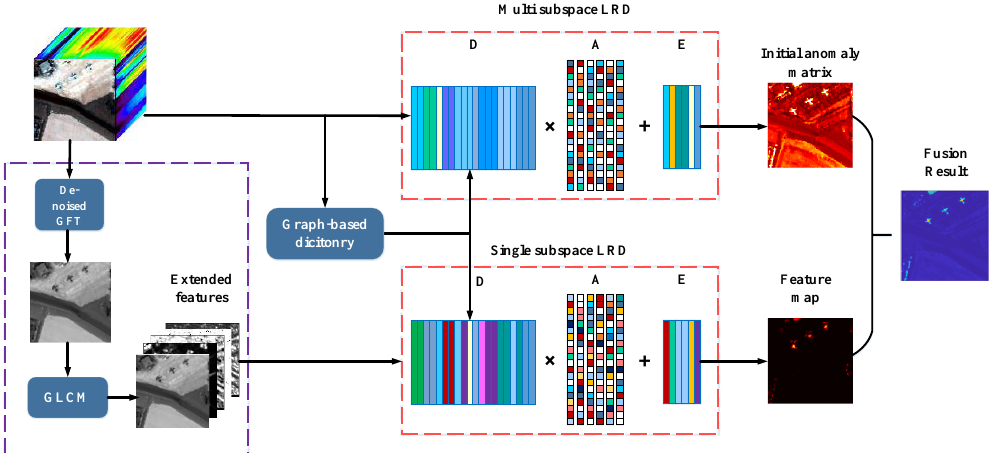
Figure 1. Flowchart of the proposed graph dictionary-based low rank decomposition with texture feature extraction (GLRD_TFE)